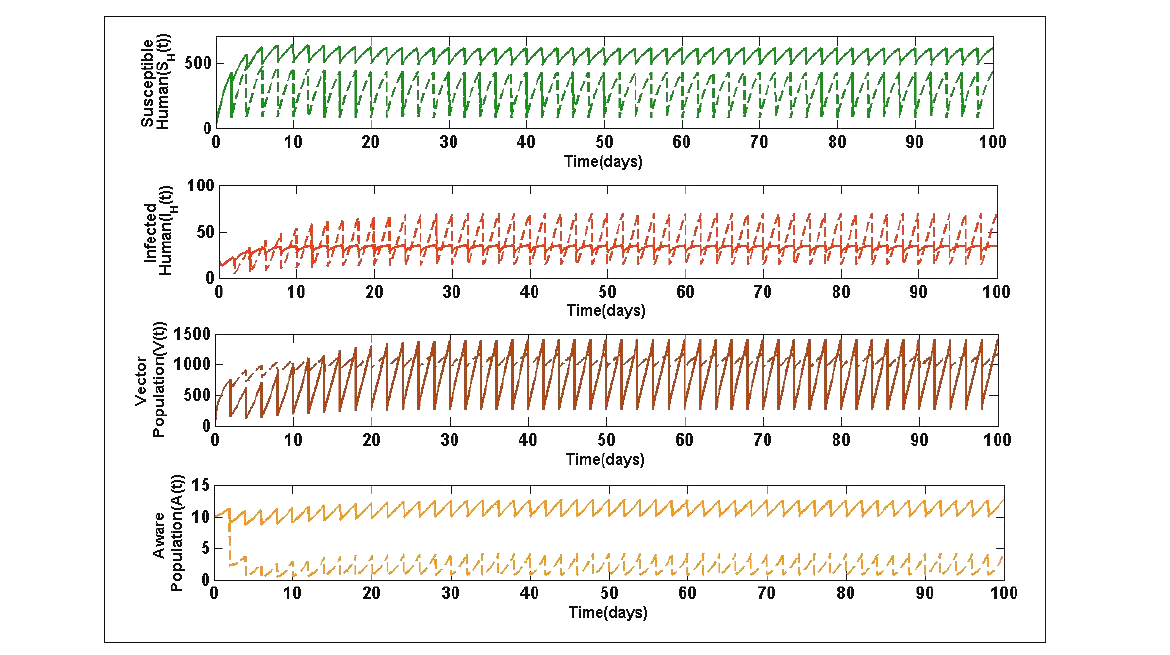
Fig. 6. The impulsive behavior of the model system with awareness campaign after two days interval with ρ = 2 (“- - -”) and ρ = 8